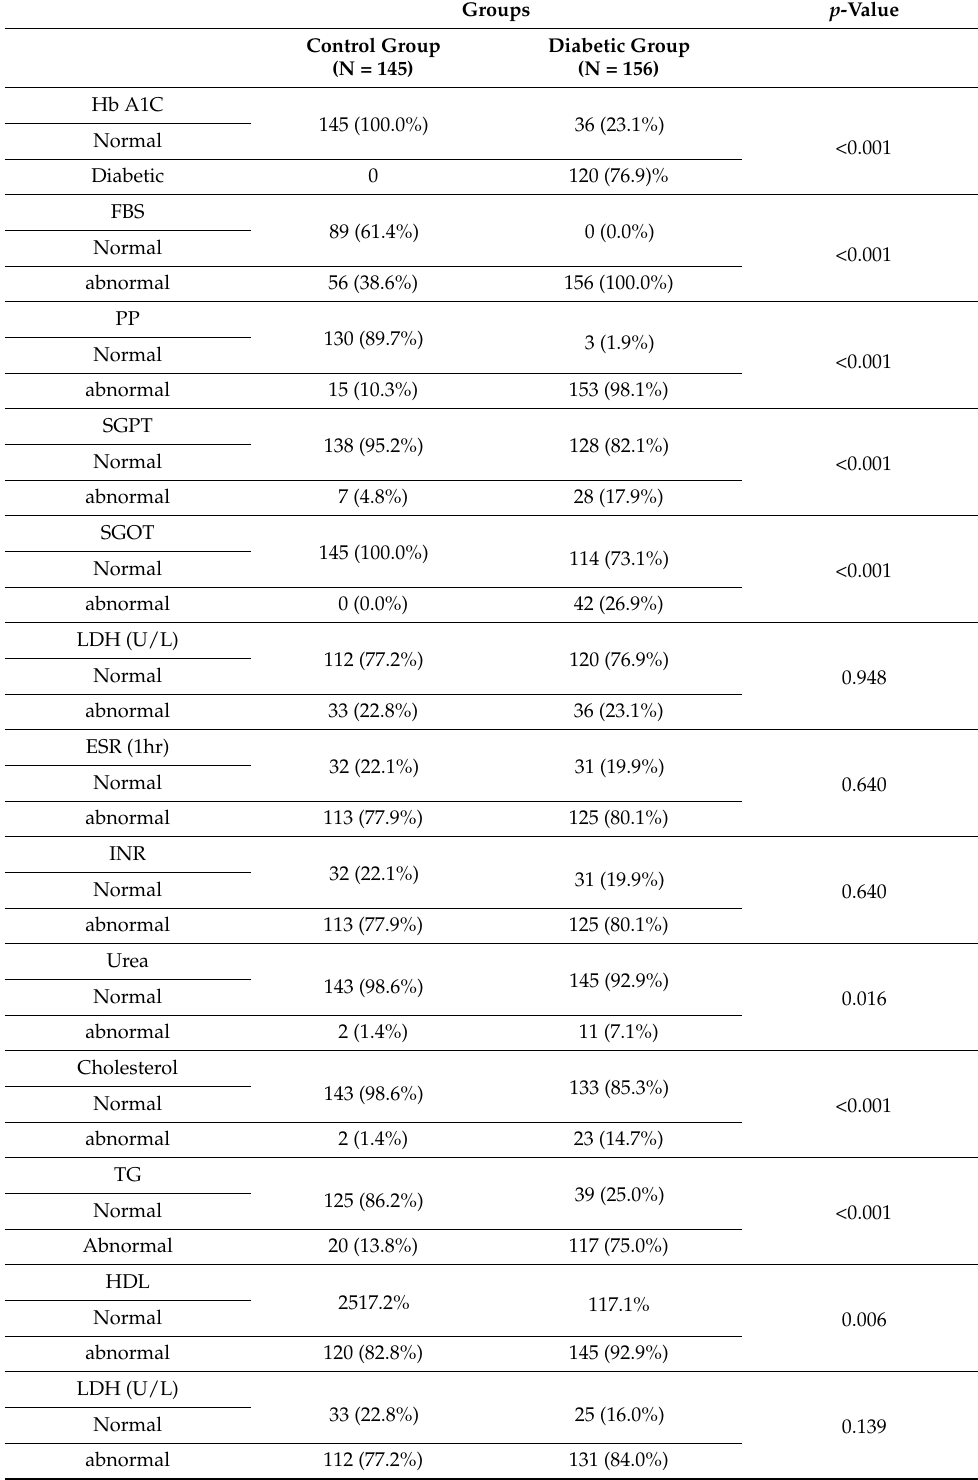
Table 3. Laboratory Finding of Studied